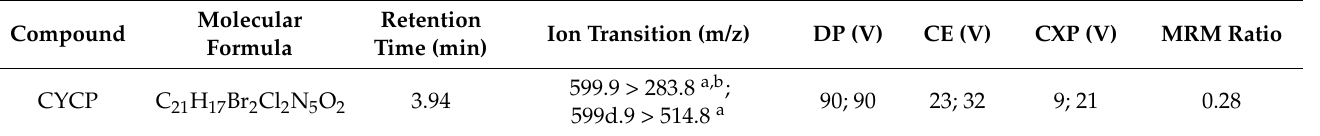
Table 3. MS/MS parameters for detection of